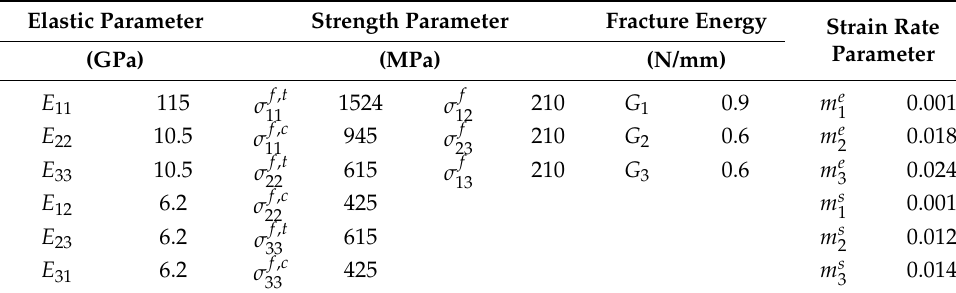
Table 2. Material parameter for AP laminate. Elastic